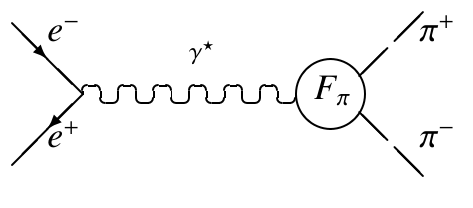
Figure 1. Electron-positron pair annihilating to a virtual photon with time-like momentum which then decays to a pion